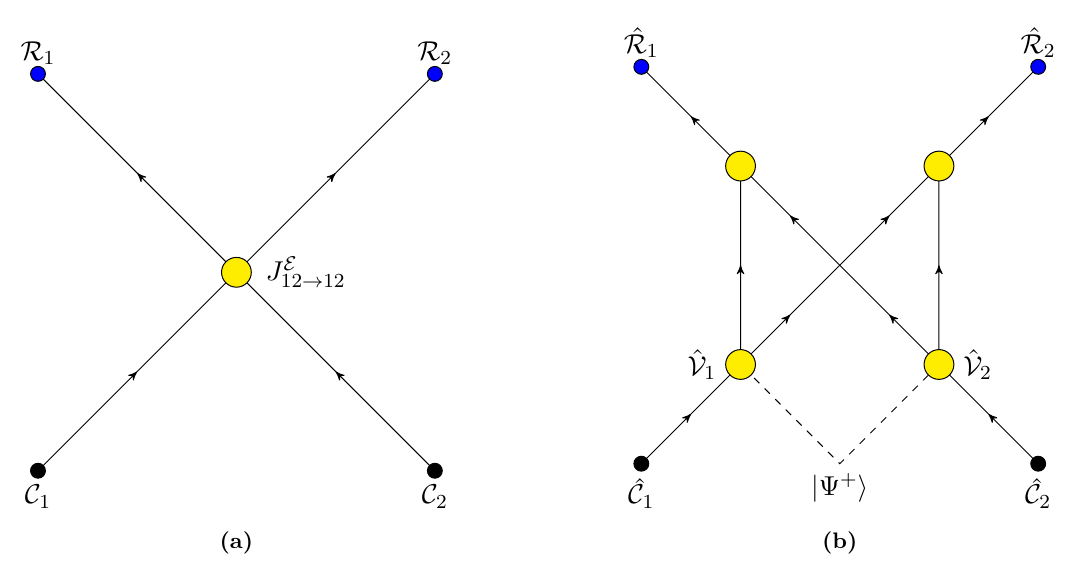
Figure 5. Bulk and boundary perspectives on the ˆB 84 task. (a) Causal features present in the bulk geometry. Signals from C and C may meet in the scattering region J E 1 2 to either R or R . The scattering region is a resource, useful for completing quantum 1 2